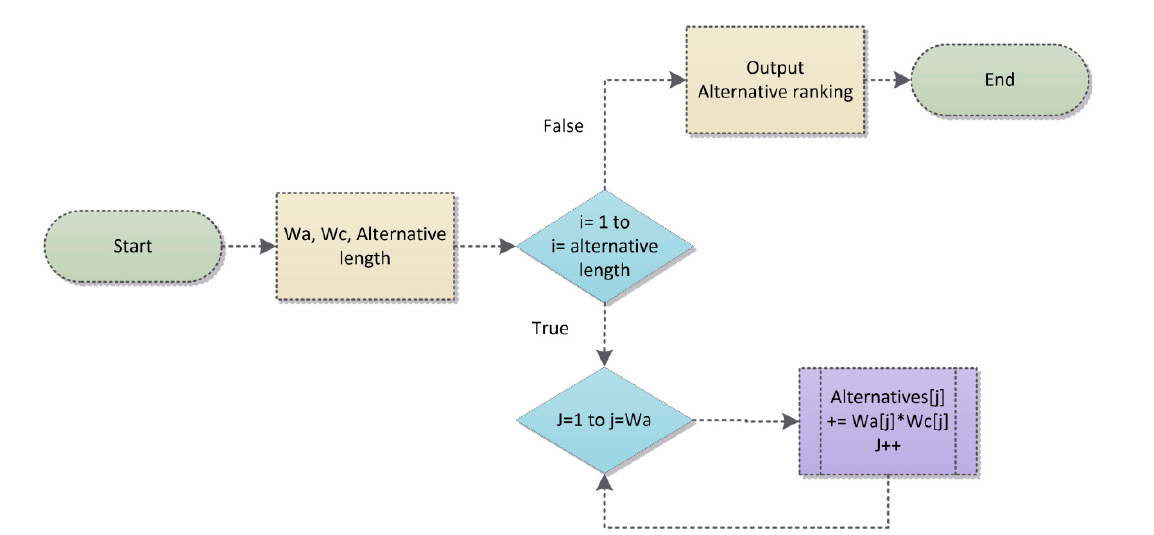
Figure 7. Flowchart of Algorithm 3 for alternatives ranking.